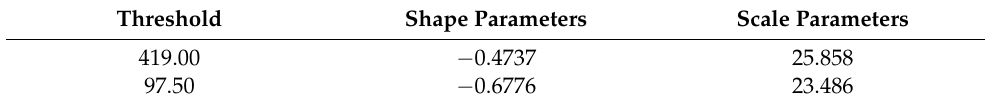
Figure 2. The time history of tractor power take-off (PTO) torque load after preprocessing. Table 2. Generalized Pareto Distribution (GPD) fitting result.